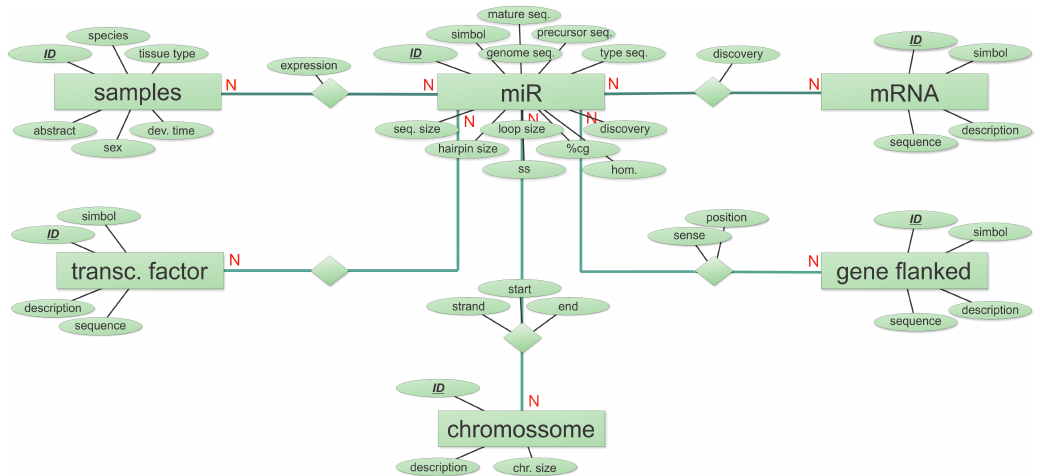
Figure 1. Entity-Relationship Diagram (ERD) for the miRTil database. Squares symbolize entities, a collection of similar data that can be distinguished and have stated relationships to other entity data; ellipses represent attributes, characteristics of stored data. Attributes can be used to guarantee data individuality (primary key); they also establish a relationship with other entities (foreign key). Primary keys are represented by underlined descriptors; diamonds represent relationships between two entities. In addition, rules of cardinality are highlighted in the